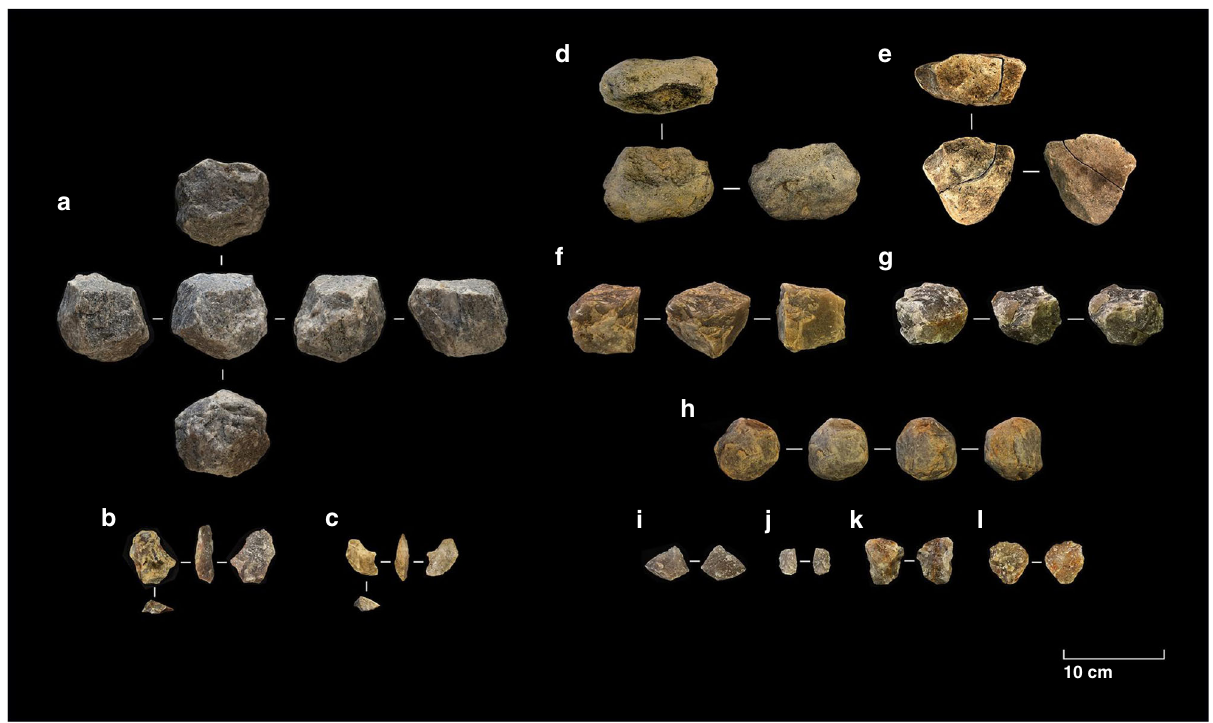
Fig. 4 Selection of stone tools from Ewass Oldupa. Ngorongoro Formation: earliest Oldowan, post Naabi, Trench 7: a Quartzite multipolar-multifacial core. b – c Quartzite fl akes. Ngorongoro Formation, Contact CFCT compositional zone/Bottom of Bed I, Trench 5: d Ignimbrite chopping-tool. e Ignimbrite chopper. f Quartzite unipolar longitudinal core. g Quartzite multipolar-multifacial core. Lower Bed I: earliest lake expansion, Trench 3: h Quartzite spheroid.